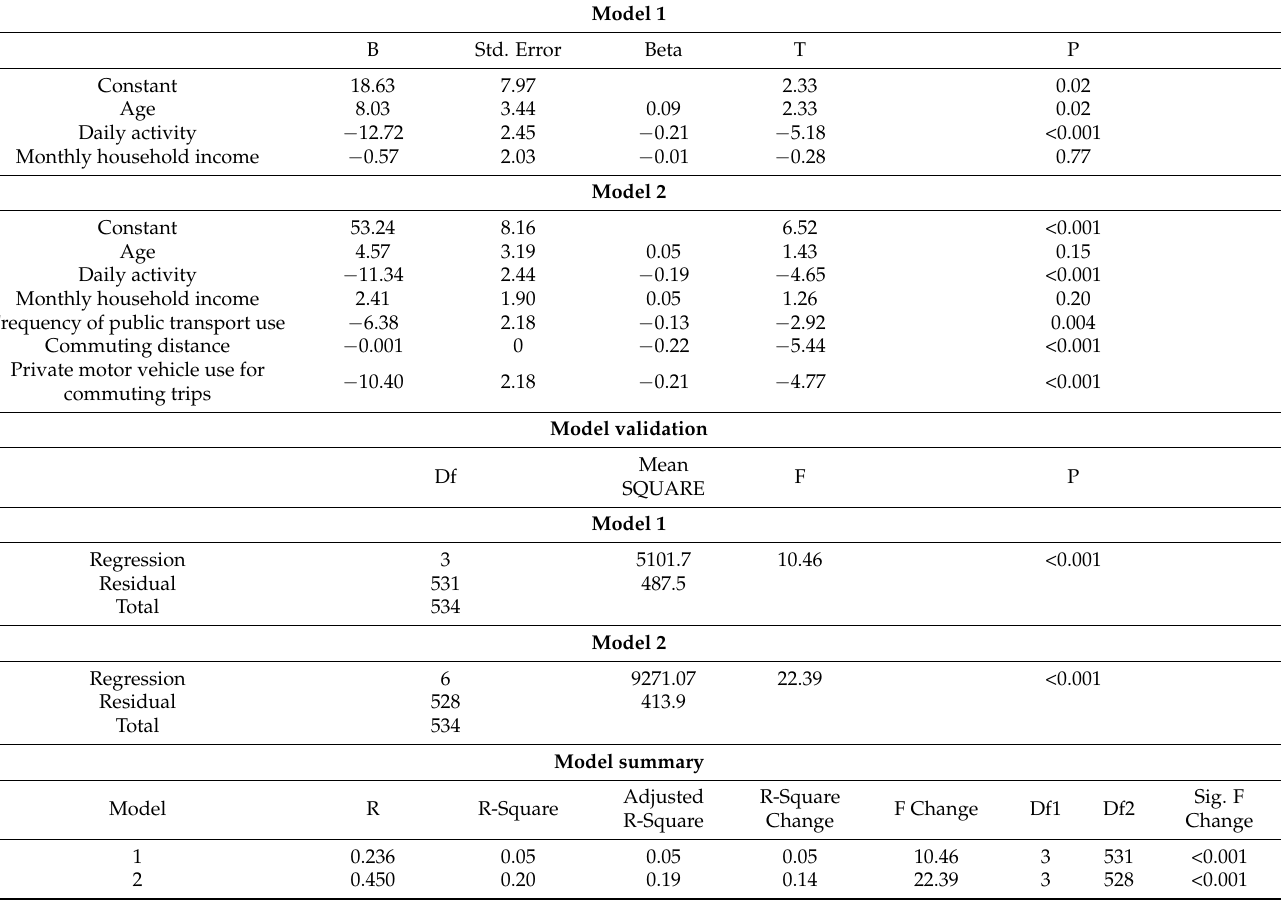
Table 3. HMR model for street-length density around